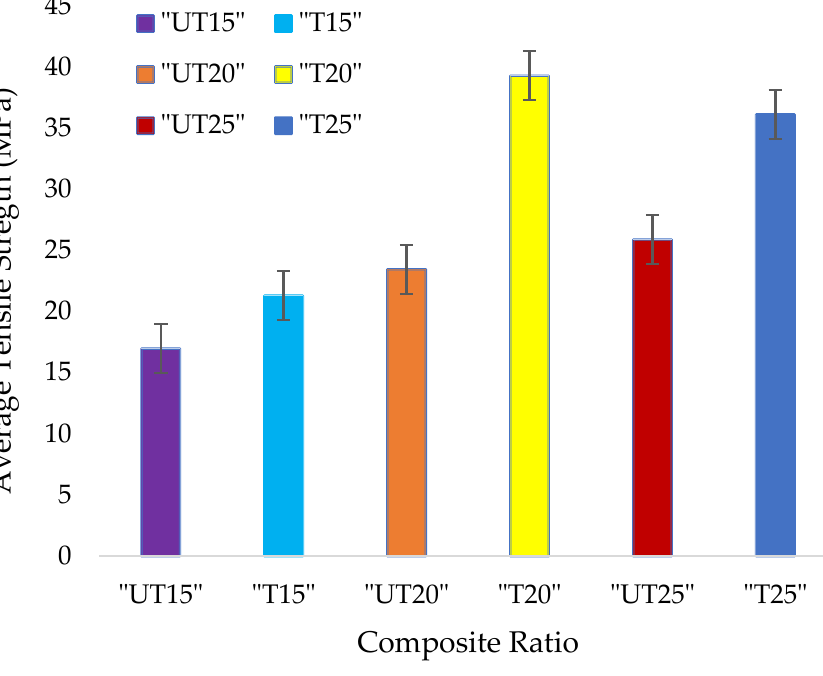
Figure 2. Tensile strength test results. UT15, UT20, UT25, T15, T20, and T25 represent 15% of untreated CH, 20% of untreated CH, 25% of untreated CH, 15% of treated CH, 20% of untreated CH and 25% of untreated CH in the composite mixtures, respectively.